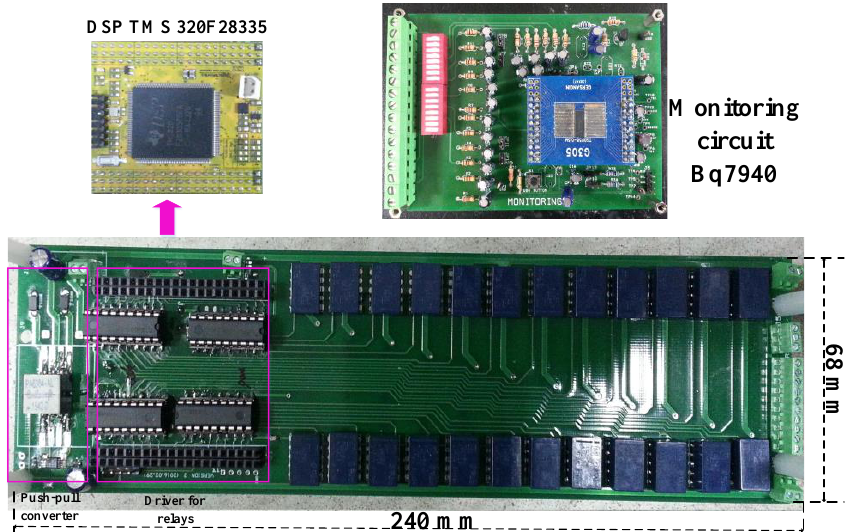
Figure 7 . Proposed cell balancing circuit for twelve Li-ion batteries. Figure 7. Proposed cell balancing circuit for twelve Li-ion Table 2 . Component list of the proposed cell balancing circuit.